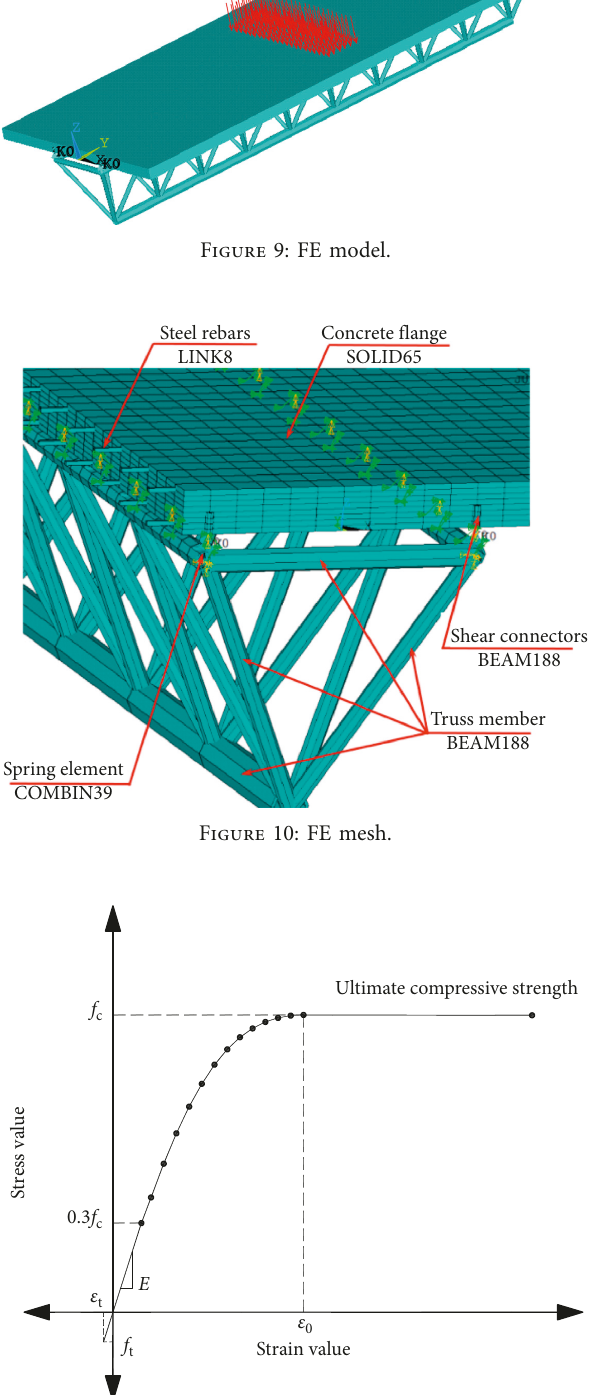
Figure 11: Stress-strain relationship for concrete.